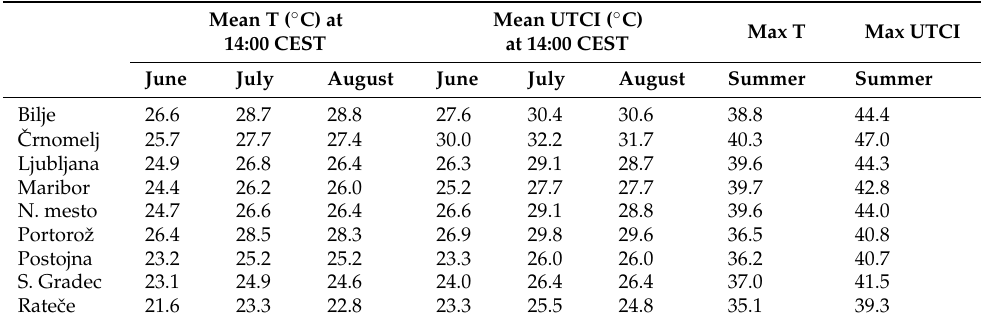
Table 5. Mean and max air temperature (T; ◦ C) and Universal Thermal Climate Index (UTCI; ◦ C) at 14:00 CEST, monthly and seasonal values for the period 2000–2021. Mean T ( ◦ C) at 14:00